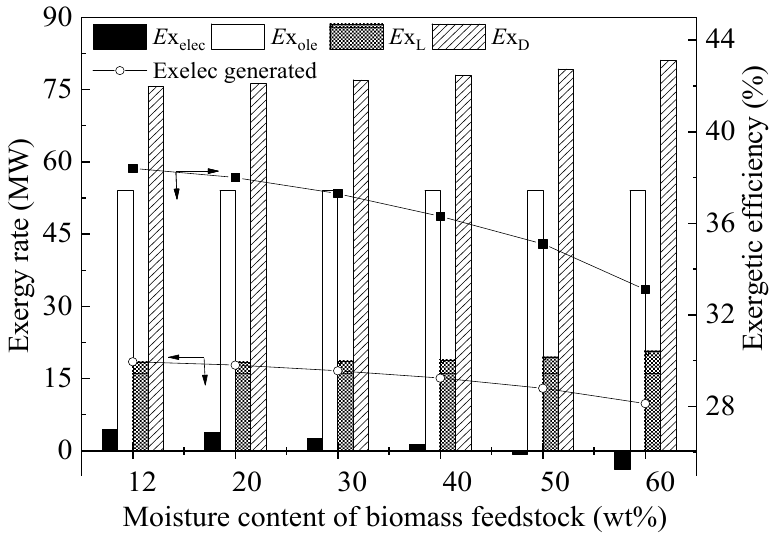
Figure 7. Effect of moisture content of feedstock on overall exergy performance for the fuel case.